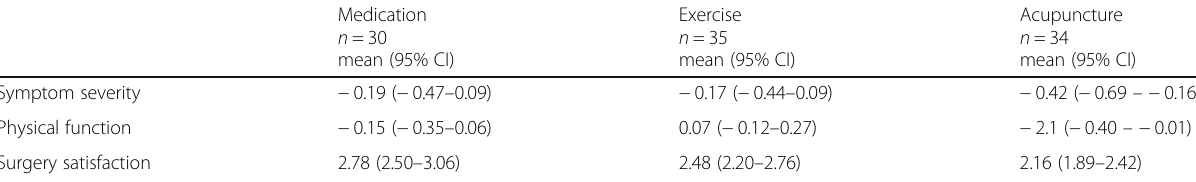
Table 2 Adjusted mean ZCQ score reductions (symptom severity, physical function) and mean ZCQ scores (surgery satisfaction)